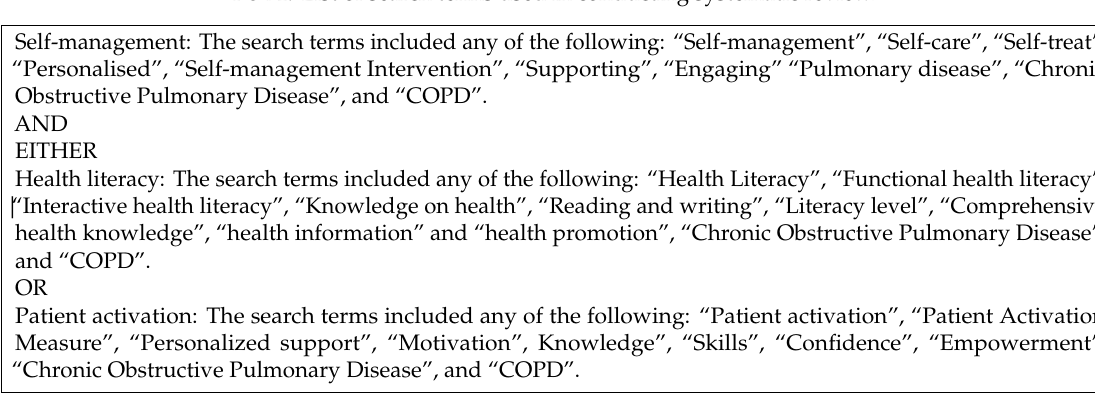
Box 1. List of search terms used in conducting systematic